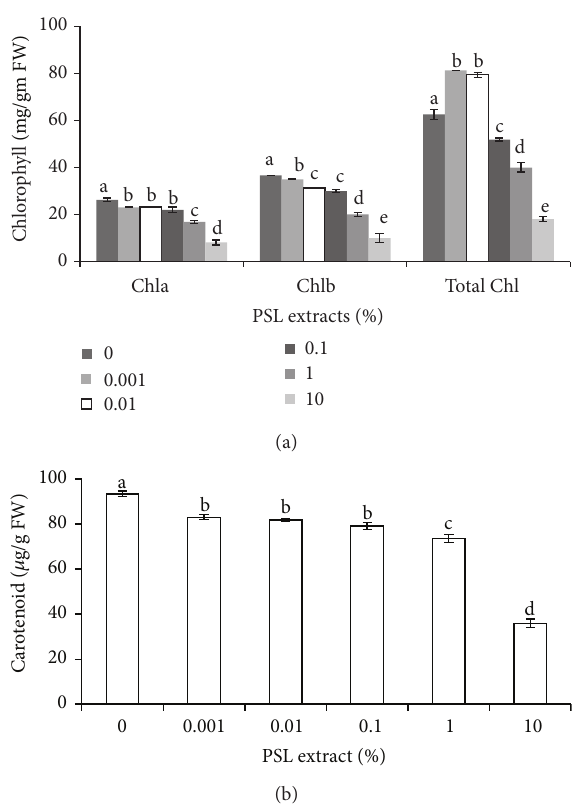
Figure 1: Effect of PSL extract on chlorophyll content (a) and carotenoid content (b) of wheat. Error bars represents Mean ± S.D of three different experiments. Data were subjected to one- way ANOVA analysis and differences among treatments were deter- mined by Tukey’s test. Different letters mean statistical differences at 𝑃 < 0.05 .